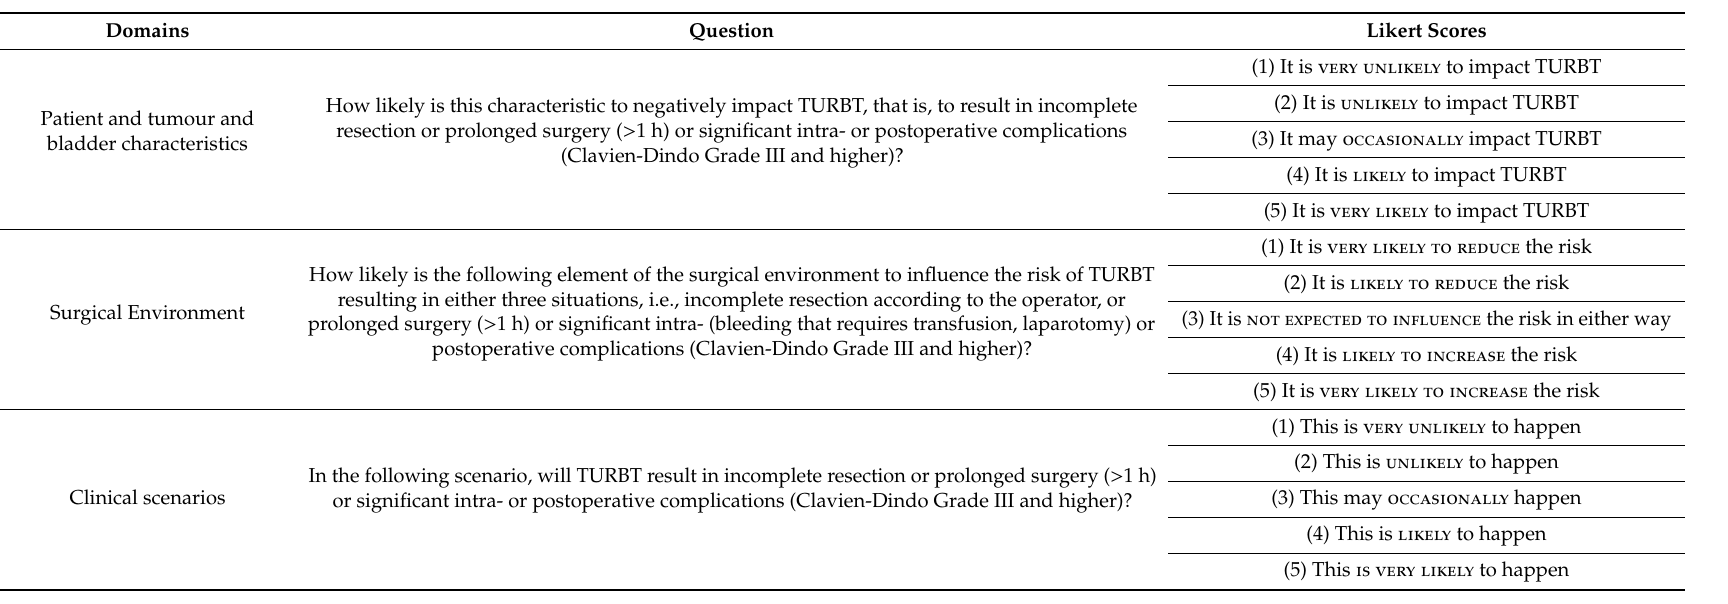
Table 5. Questions and Likert scores for complexity and patient and tumour’s characteristics and surgical